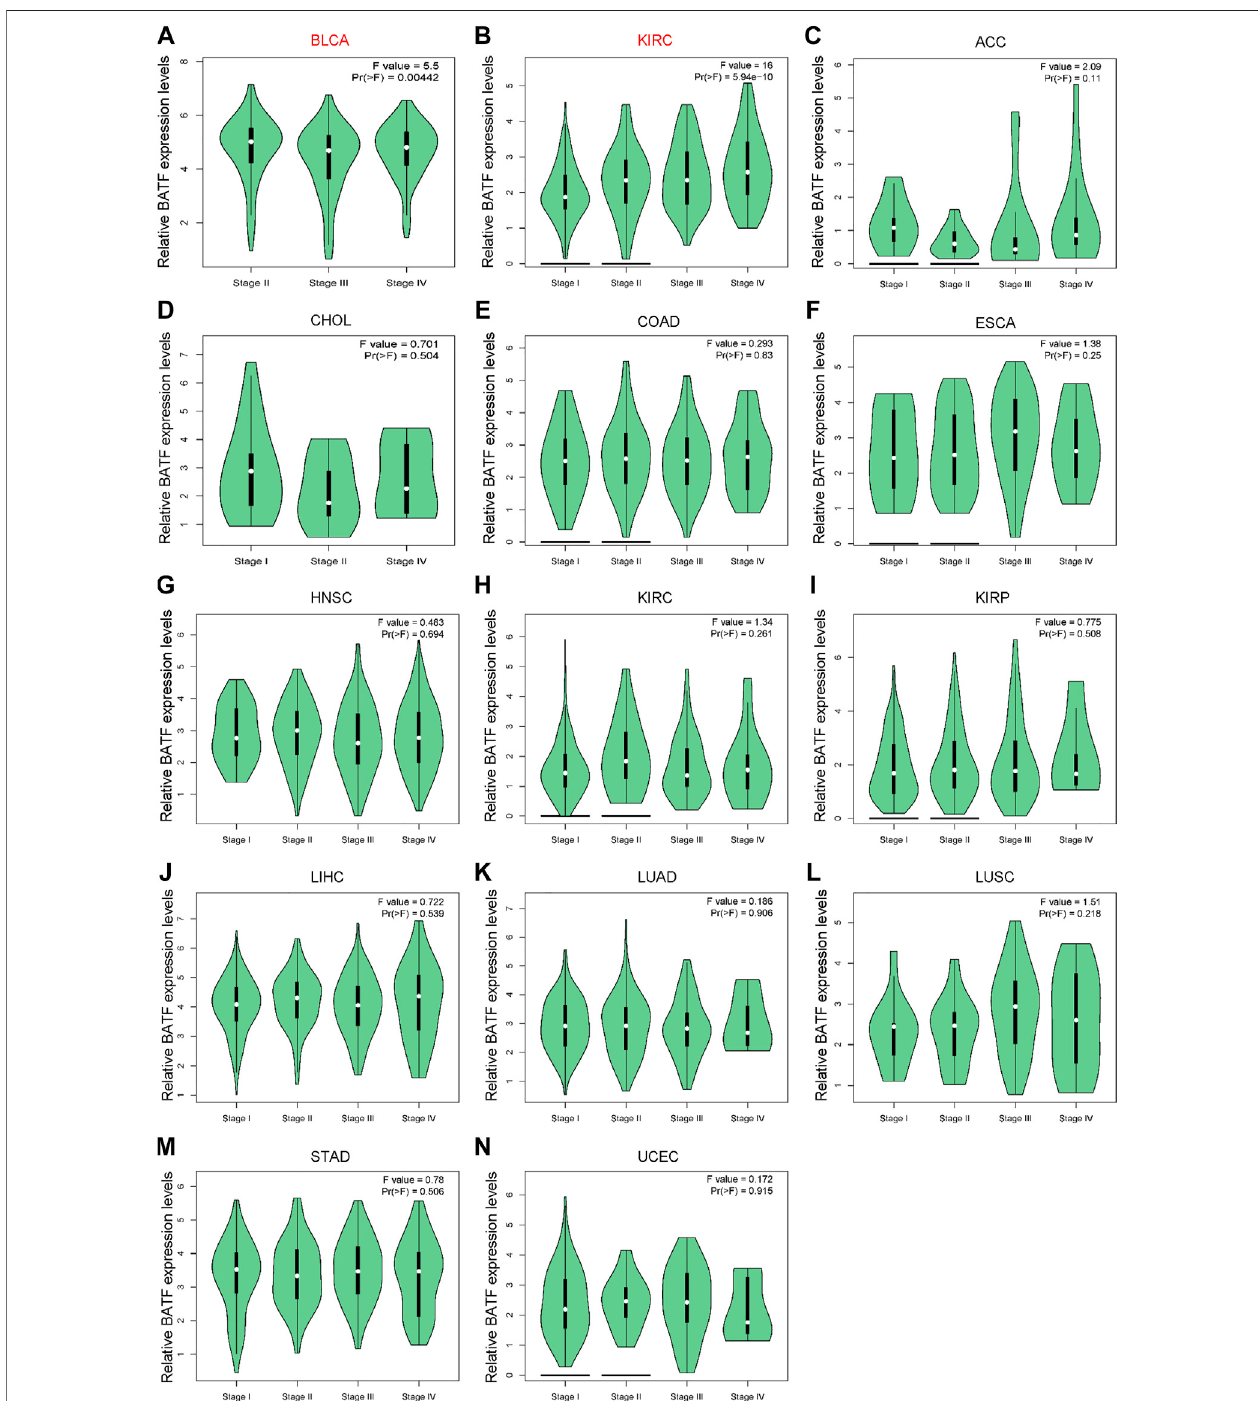
FIGURE 2 | Correlation between aberrant BATF expression and clinicopathological stages in tumors. Red fonts indicate signi fi cant differences among these groups, while black fonts indicate no statistically signi fi cant differences.